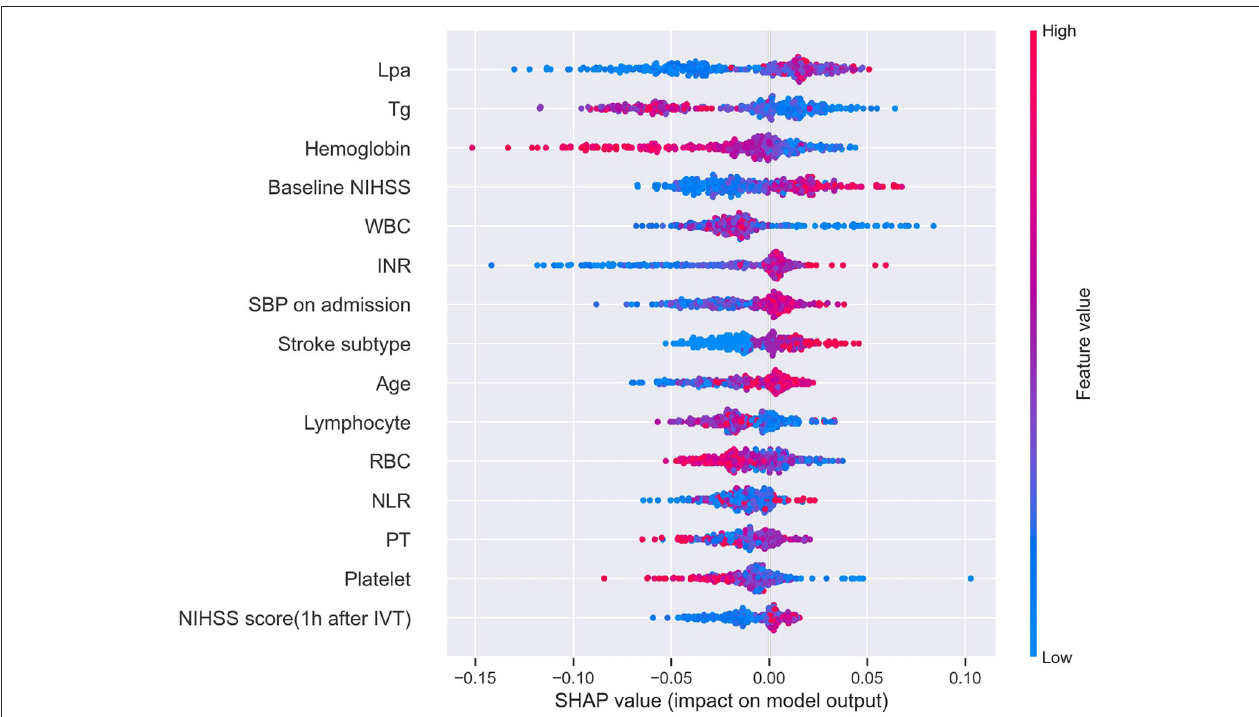
FIGURE 5 | SHAP summary plot of the top 15 features of the RF model. The higher the SHAP value of a feature ( x -axis), the higher the probability of HT after IVT. Taking the feature Lpa as an example, red points are on the right whereas blue points are on the left. This means prediction scores will be smaller when patients have a low level of Lpa. SHAP, SHapley Additive exPlanation; RF, random forest; HT, hemorrhage transformation; IVT, intravenous thrombolysis; Tg, triglycerides; WBC, white blood cell; RBC, red blood cell; NLR, neutrophil-to-lymphocyte